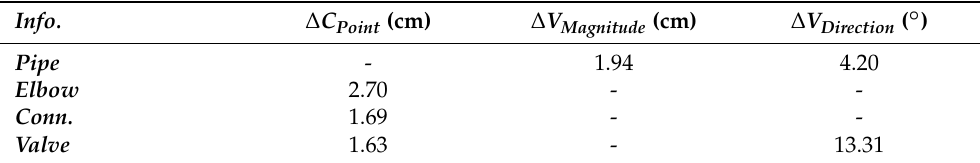
Table 5. IEA metrics on T BASE and T EXTRA test